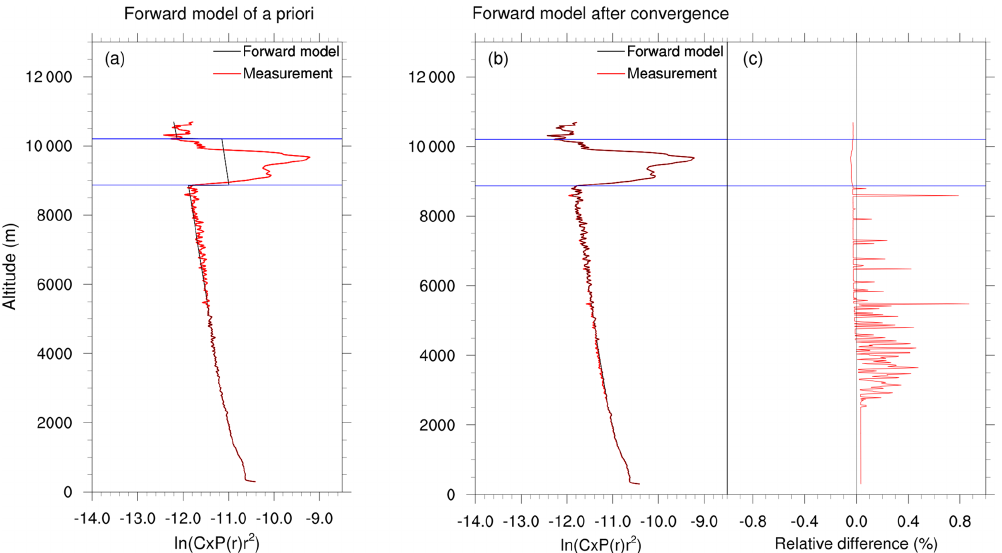
Figure 10. Lidar forward model of the (a) a priori state vector and (b) after the last iteration step (represented by the black lines) from the synergy algorithm for the lidar profile measured on 30 November 2016 at 18:11UTC. The red lines represent the measurement; the horizontal blue lines indicate the defined cloud-base and cloud-top altitudes. (c) Relative difference between the forward model and the measurement after convergence.